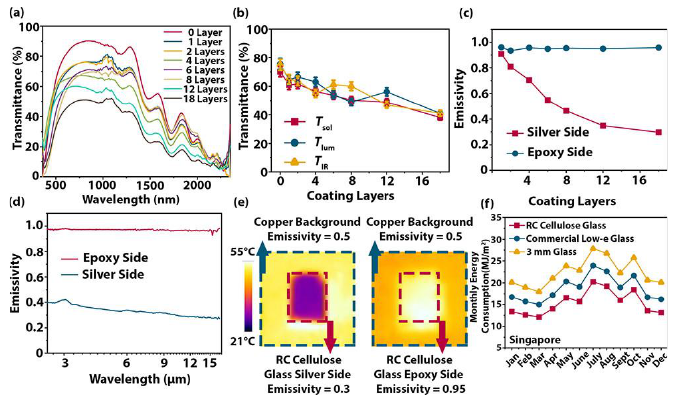
Figure 28. ( a ) UV–vis–NIR spectra of the radiative cooling transparent bamboo with various numbers of silver nanowire layers; ( b ) integrated T sol (solar transmittance), T lum (luminous transmittance), and T IR (infrared transmittance) values of the radiative cooling transparent bamboo as a function of the number of silver nanowire layers; ( c ) emissivity of the radiative cooling transparent bamboo as a function of the number of silver nanowire layers; ( d ) long-wavelength infrared emissivity spectrum of the two sides (one coated with 18 layers) of the radiative cooling transparent bamboo; ( e ) IR image of both sides (one coated with 18 layers) at 50 ◦ C, using a 0.5 emissivity copper block as the background; ( f ) simulated monthly energy consumption in Singapore when 3 mm conventional glass, commercial low-E glass, and radiative cooling transparent bamboo are used. Reprinted with permission from [43], copyright 2021, American Chemical Society.